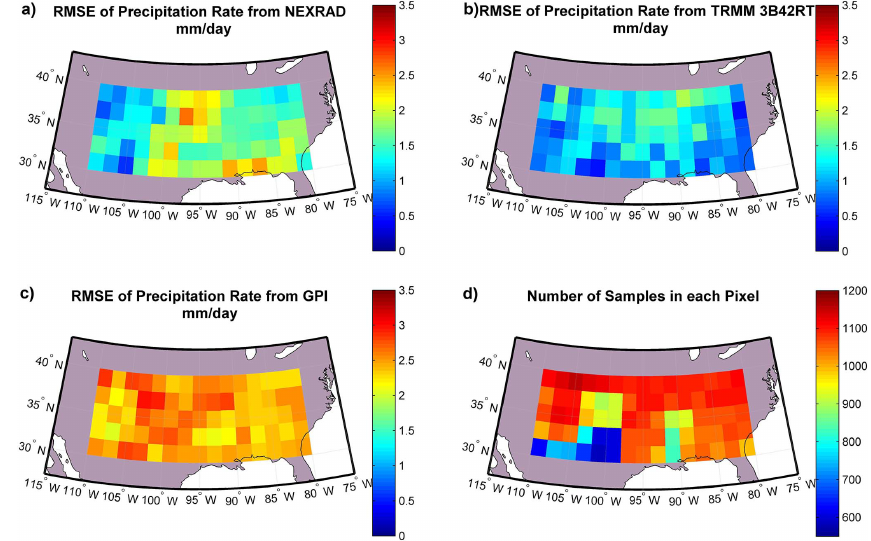
Figure 5. RMSE of the precipitation rate estimated from TC using triplets in group 1; (a) NEXRAD, (b) TRMM 3B42RT, (c) GPI. (d) shows the number of data points (biweekly measurements) in each pixel that are used for error estimation in TC analysis.